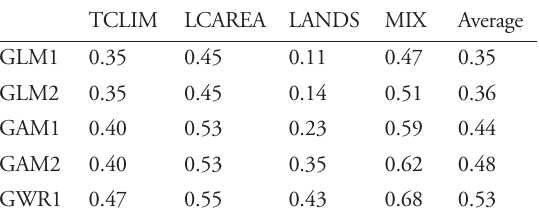
Table 3. Willmott’s D-values for each model using the different regression approaches. Average of D-values was obtained for each type of